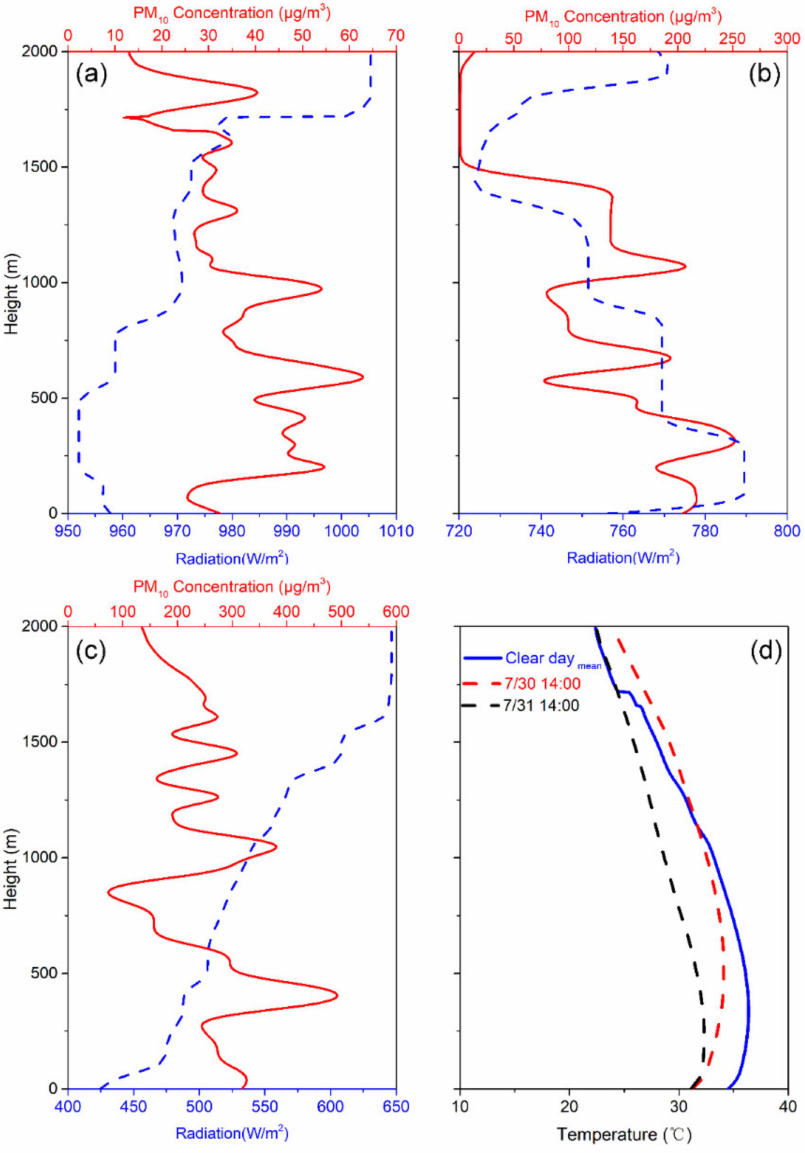
Figure 8. Vertical distribution of PM 10 concentration, radiation, and temperature at 14:00 on 30–31 July 2021 in TZ, ( a ) mean of clear days; ( b ) 30 July 2021; ( c ) 31 July 2021; ( d ) temperature. Normally, since the ABL sufficiently developed during the day and stabilized at night, the ABL height was measured at 14:00 (the convective boundary layer, CBL) and 02:00 (the stable boundary layer, SBL) [29]. The vertical distribution of the potential temperature under different pollution conditions during July 2021 in TZ and MF is shown in Figure